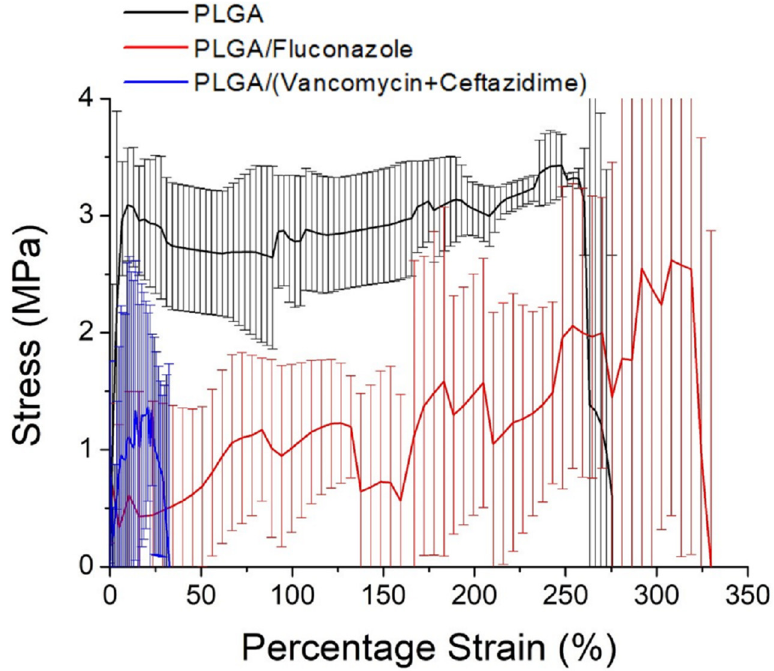
Figure 3. Tensile properties of electrospun drug-eluting nanofibers.